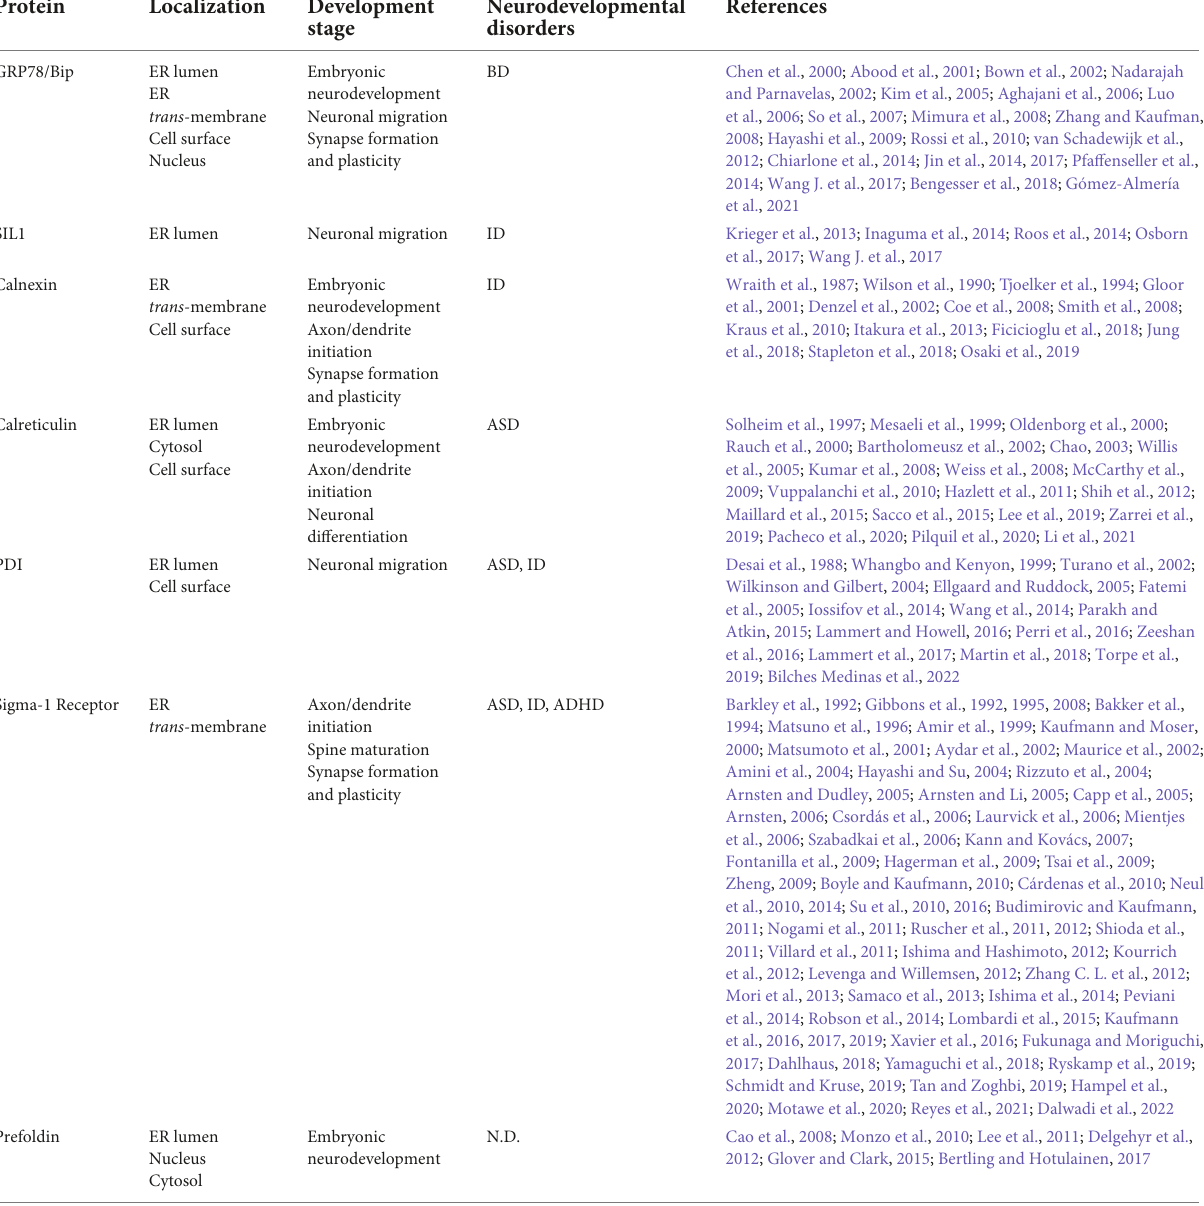
TABLE 1 The role of Endoplasmic reticulum (ER) chaperones in neural development.